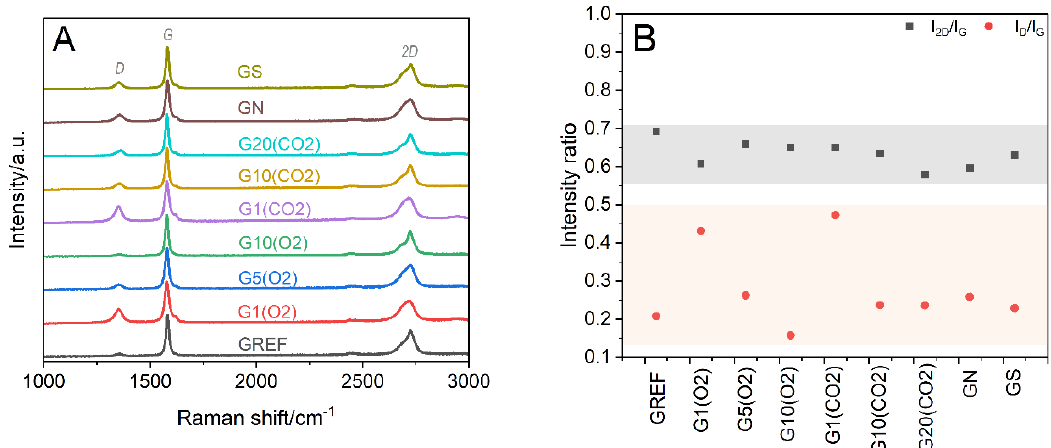
Figure 5. ( A ) Raman spectra of reference (GREF) and oxidized samples: treated with O 2 plasma for 1 min—G1(O2), 5 min—G5(O2), 10 min—G10(O2); treated with CO 2 plasma for 1 min—G1(CO2), 10 min—G10(CO2), 20 min—G20(CO2); treated with nitric acid (GN), and treated with sulfuric acid (GS). ( B ) Analysis of I D /I G and I 2D /I G intensity ratios from Raman spectra of studied samples.